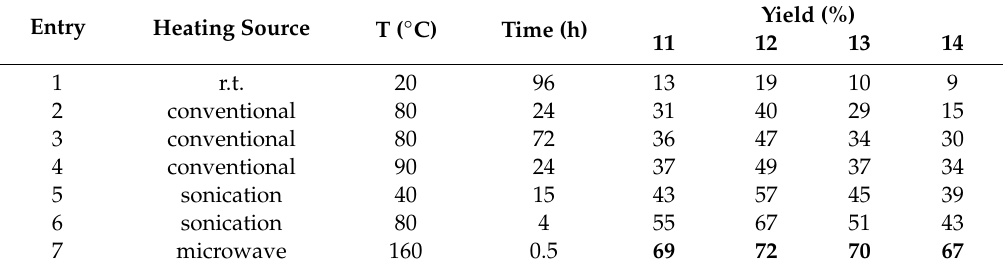
Table 3. Optimization of reaction conditions for the synthesis of compounds 11 – 14 . 1,2.